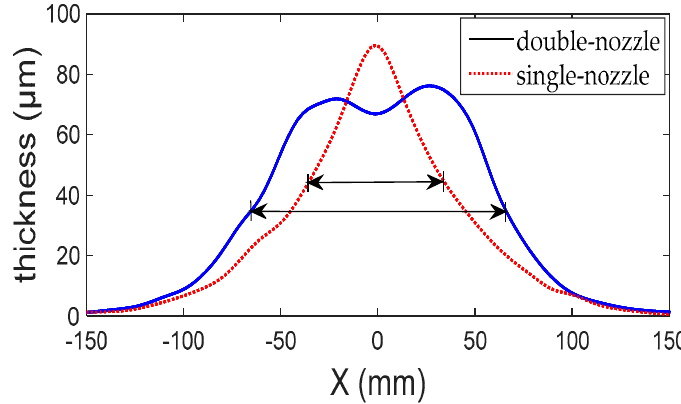
Figure 17. Comparison of coating thickness profiles along the x -axis between double-nozzle and single-nozzle air spray guns.